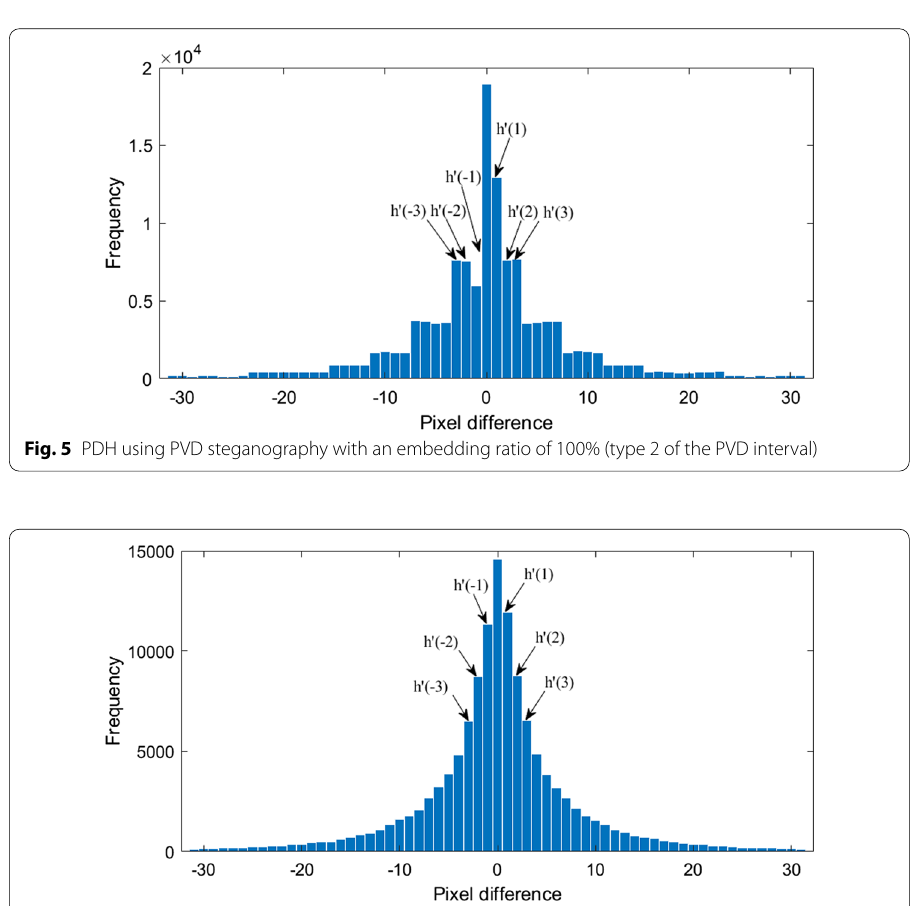
Fig. 6 PDH using PVD steganography with an embedding ratio of 10% (type 2 of the PVD